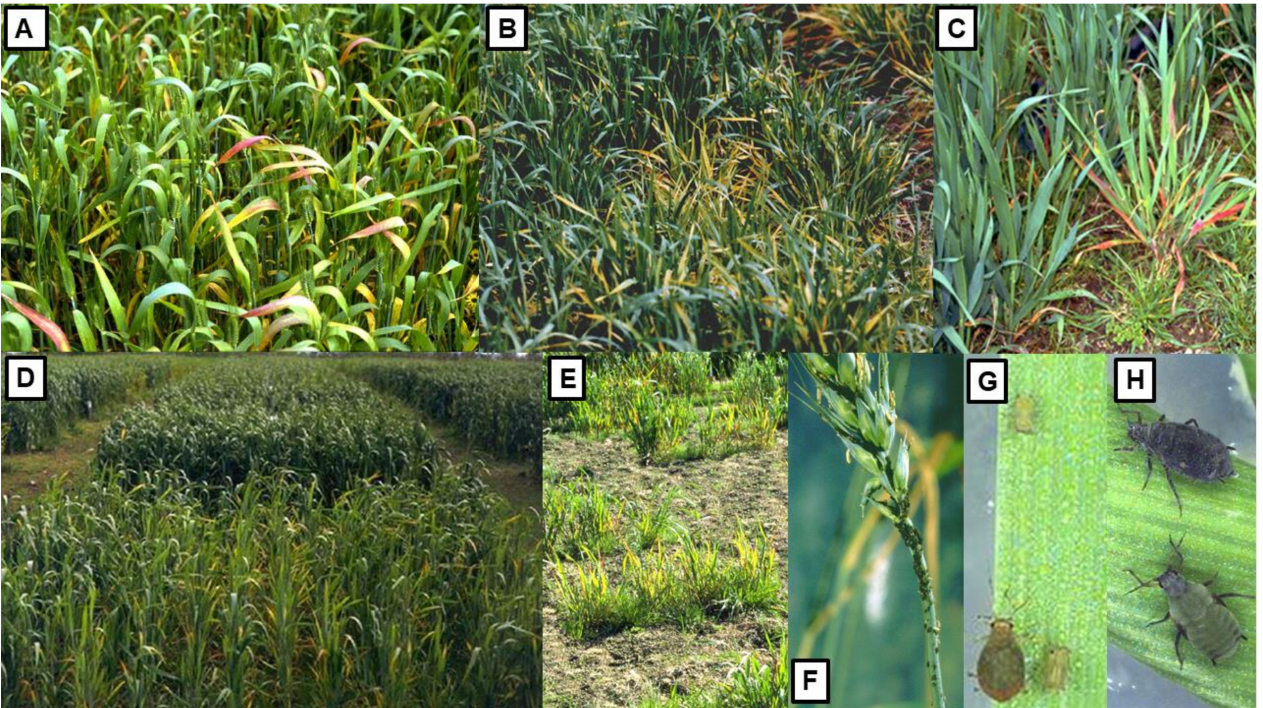
Figure 3. YDV symptoms in cereals, and cereal aphid vector, images from Australia. ( A ), Wheat crop with YDV-infected plants showing reddening and yellowing of flag leaves and lower leaves. ( B ), Barley crop showing a patch of YDV-infected plants (bottom right) and healthy more vigorous plants (top left and center). ( C ), Oat crop with YDV-infected plant showing reddening of lower and chlorosis of upper leaves and stunting (right), other oat plants healthy and vigorous. ( D ), Untreated control plot of wheat containing stunted YDV-infected plants with chlorosis and reddening of leaves (front), insecticide-treated plot containing vigorous healthy plants (behind). ( E ), Single row plots in YDV resistance evaluation trial showing infected wheat plants with leaf yellowing and reddening and severe stunting. ( F ), Heading tiller of wheat heavily colonized by the YDV vector Rhopalosiphum padi . ( G ), An adult wingless R. padi with two young offspring. ( H ), Two adult wingless adults of the YDV vector R. maidis . ( G , H ) image credits @Department of Primary Industries and Rural Affairs/D. Thackray. Images ( A , E ) modified from